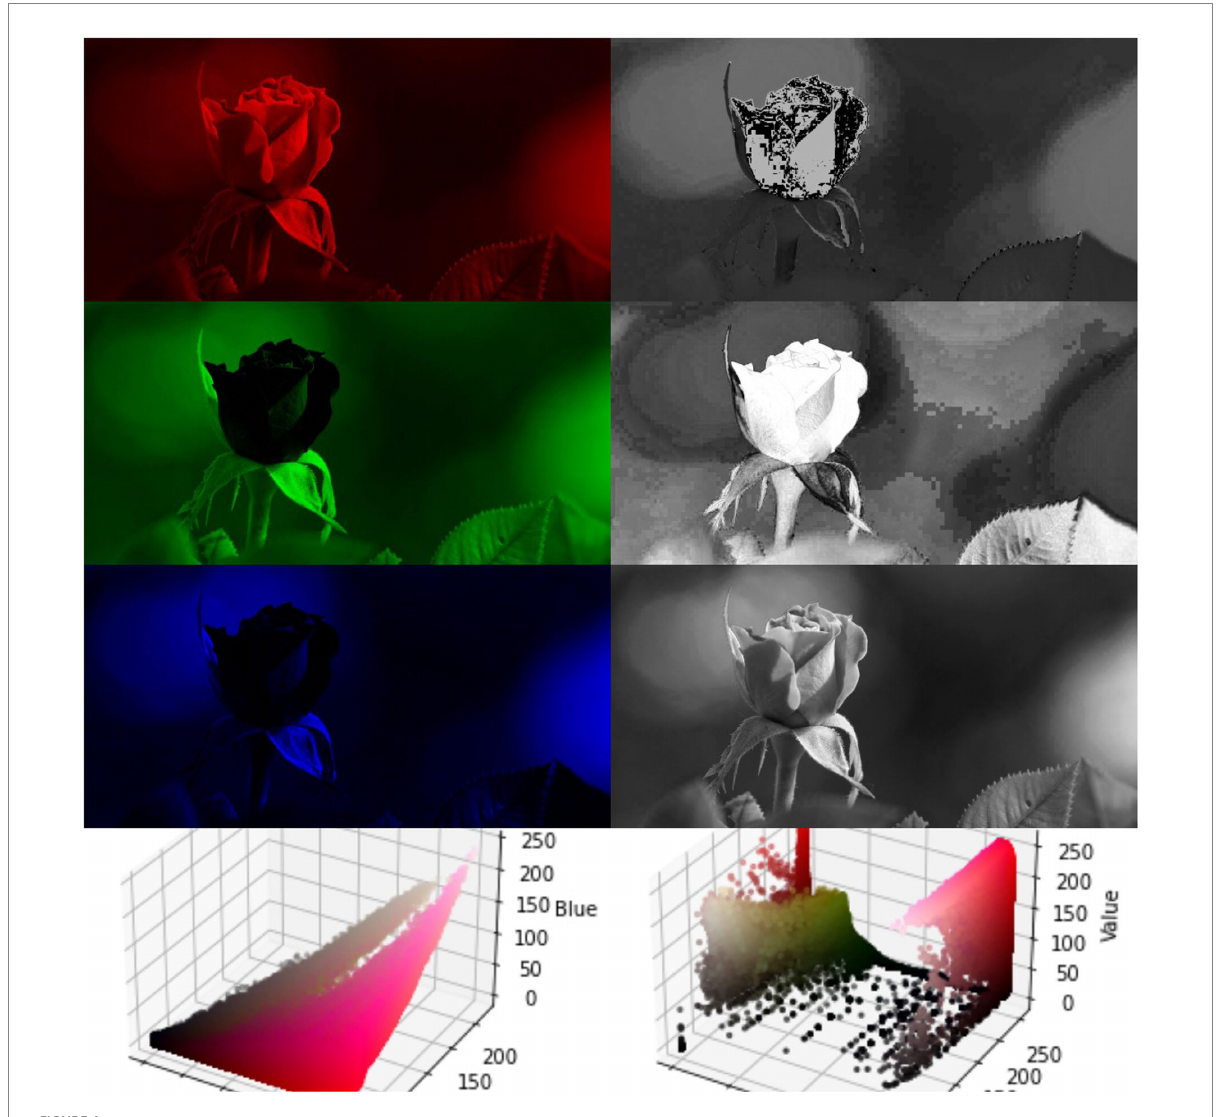
FIGURE 4 Comparison of RGB and HSV